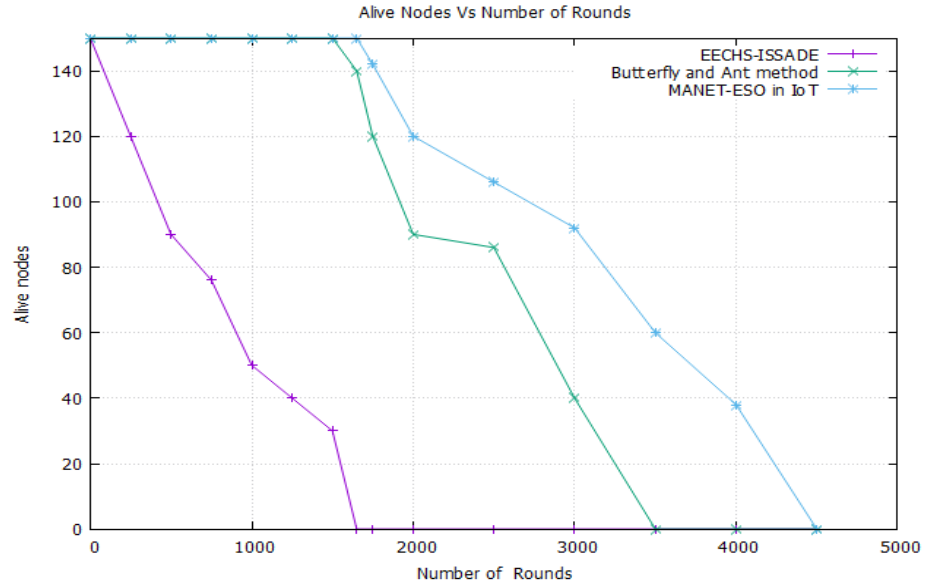
Figure 2. Live nodes vs. number of rounds.